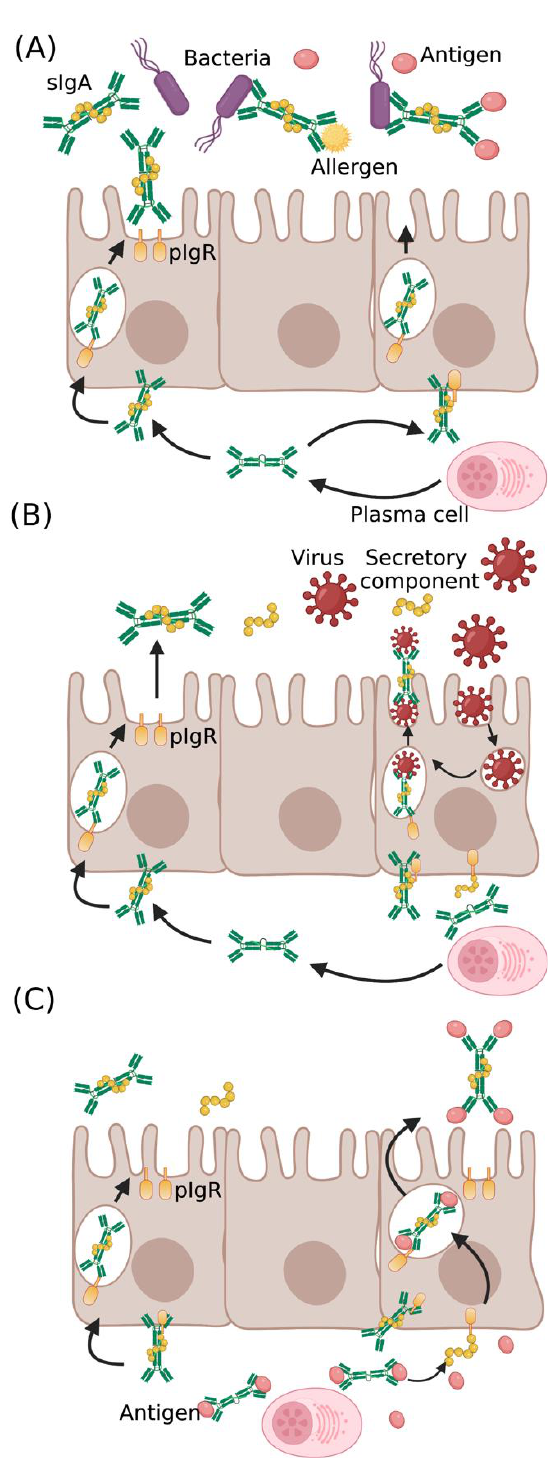
Figure 1. Protective role of IgA in pathogen neutralization and antigen clearance: IgA at the mucosal surface provides ( A ) cross-protection against diverse pathogens and antigens, ( B ) intracellular virus neutralization in infected epithelial cells, and ( C ) antigen clearance from lamina propria through the complex formation of antigen with IgA – pIgR complex (sIgA — secretory IgA, pIgR — polymeric Ig receptor).